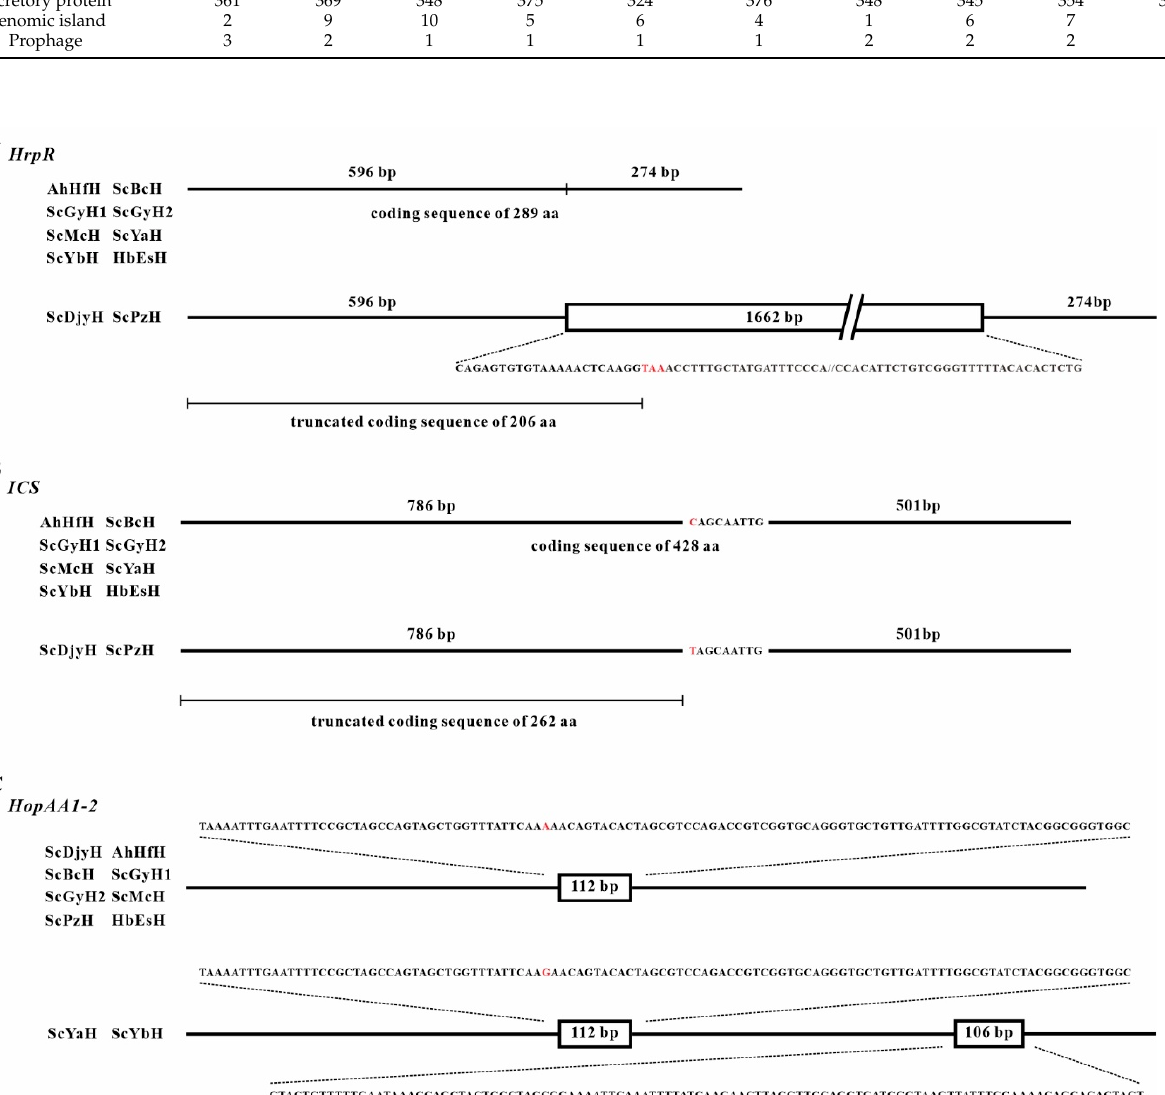
Figure 3. Schematic diagram of HrpR ( A ), ICS ( B ), and type III effector HopAA1-2 ( C ). The black lines represent gene structure. The boxes of ‘1662 bp’, ‘112 bp’, and ‘106 bp’ indicate where the mobile elements are inserted. The corresponding insertion sequences are shown by open dots. The stop codon TAA in the insertion of HrpR , C/T mutation in ICS, and A/G polymorphism in the insertion fragment of HopAA1-2 are highlighted in red.